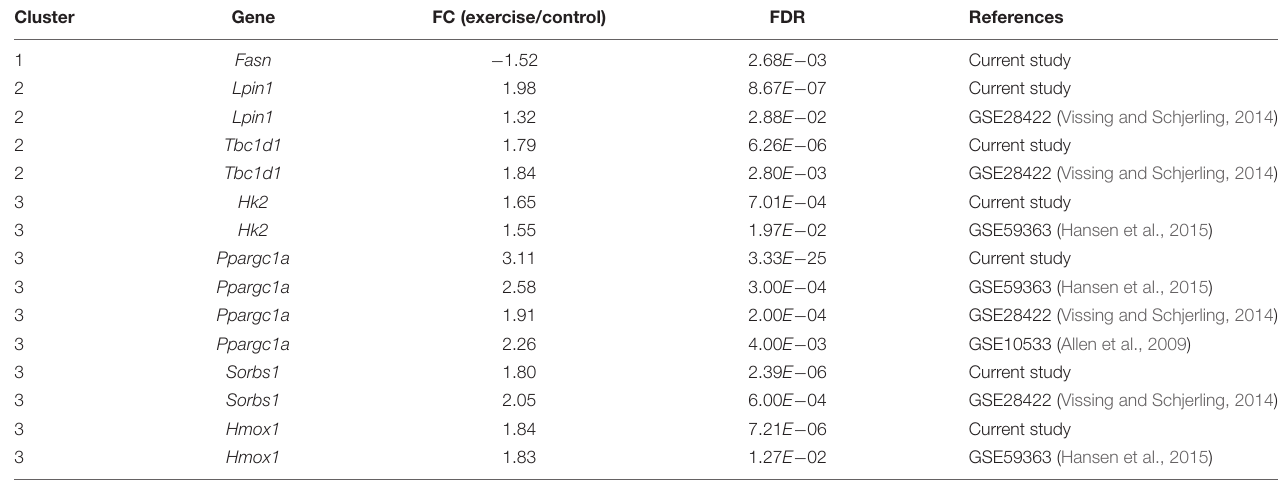
TABLE 1 | The details of key DEGs in the exercise GK rats and other